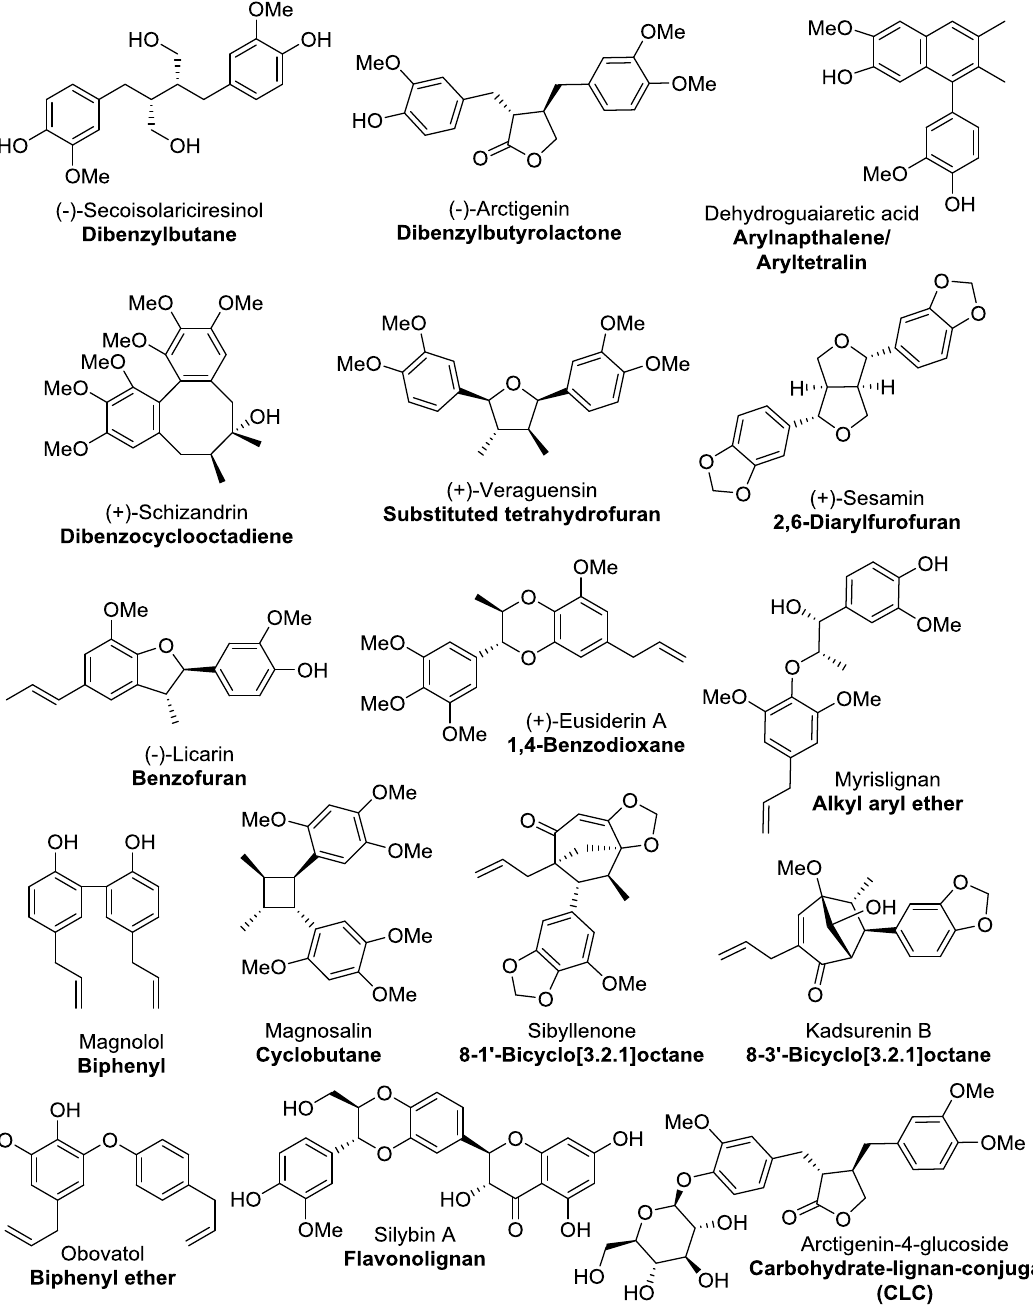
Figure 1. Examples of the six types of classical lignans, the eight types of neolignans investigated in